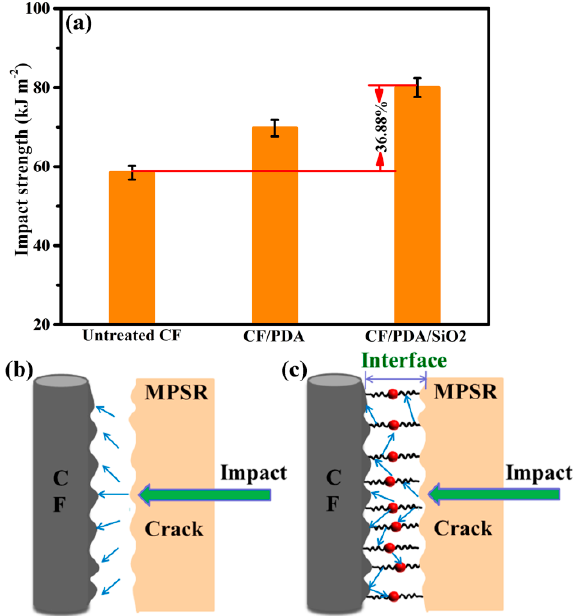
Figure 7. Impact testing results of composites and schematic of impact testing of composites reinforced with ( a ) untreated CF and ( b ) CF/PDA/SiO 2 .